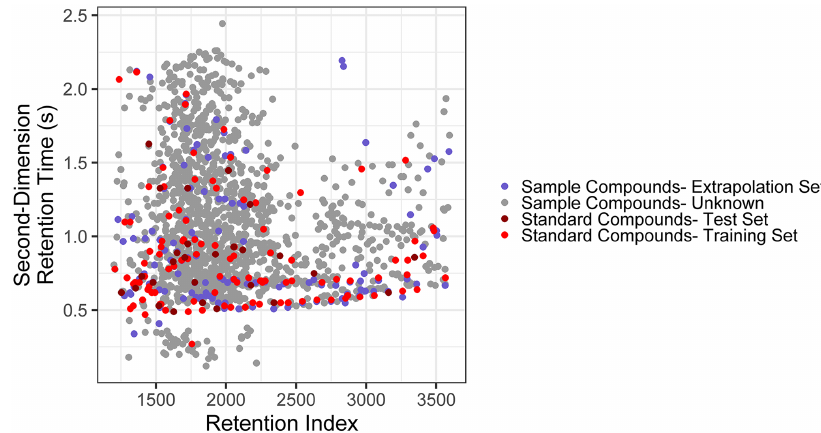
Figure 2. Distribution of training, test, extrapolation, and unidentified sample compounds in two-dimensional chromatographic chemical properties space. Table 1. Tuning parameters and important features for chemical properties prediction models. m/z indicates charged fragment features, and n indicates neutral mass difference features. Note: tree diversity feature restriction parameter is